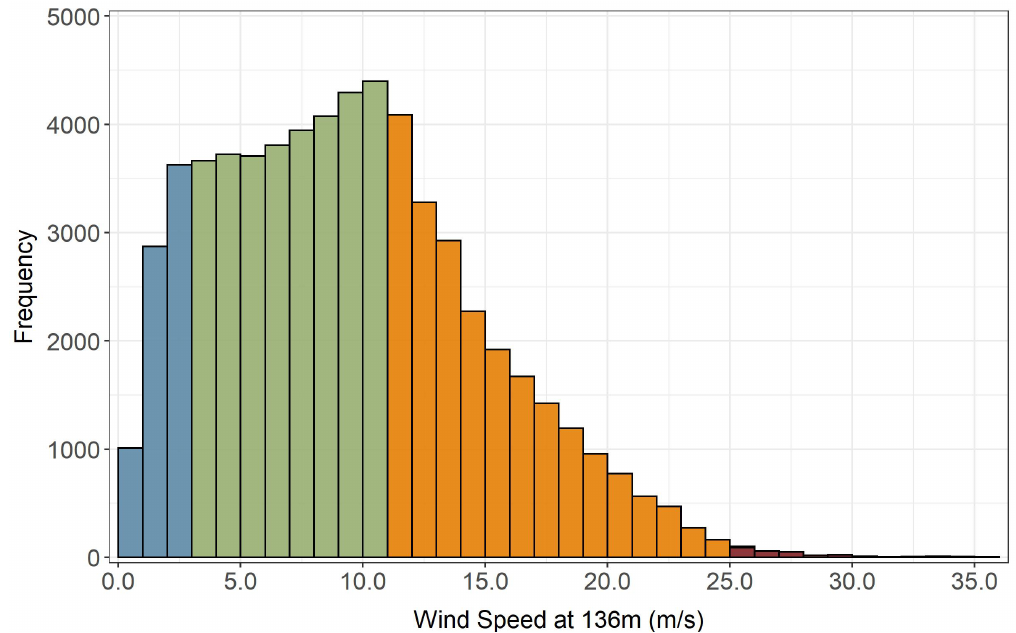
Figure 7. Histogram of wind speed and in the Humboldt Call Area. The y -axis is hours of occurrence over the seven-year period of